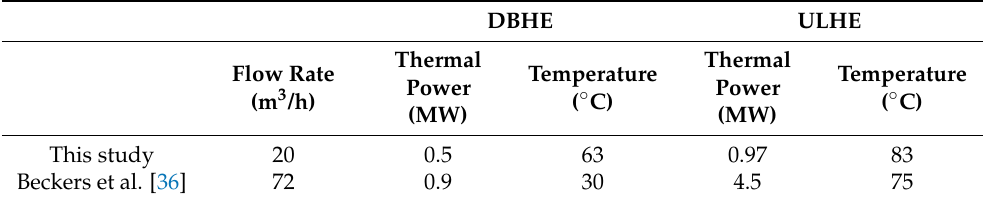
Table 5. Comparison of performance with data from Beckers et al. [36].